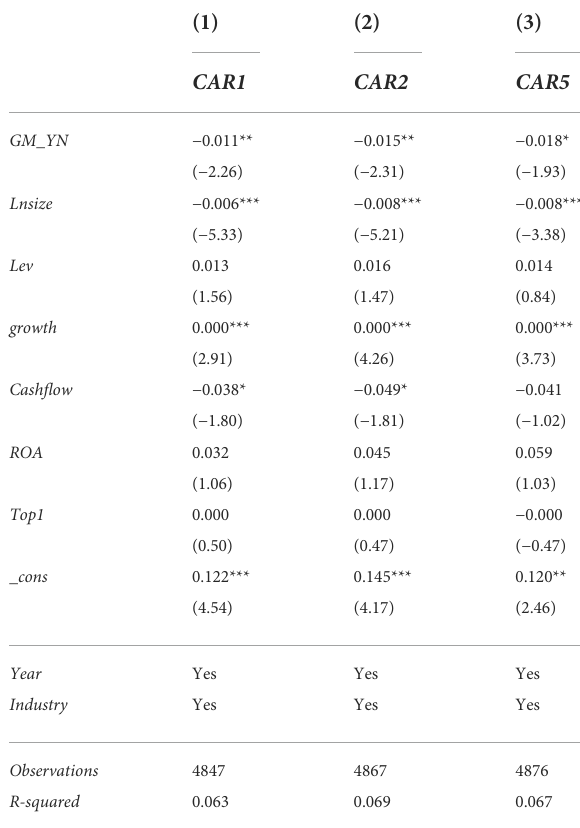
TABLE 10 Short-term M&A